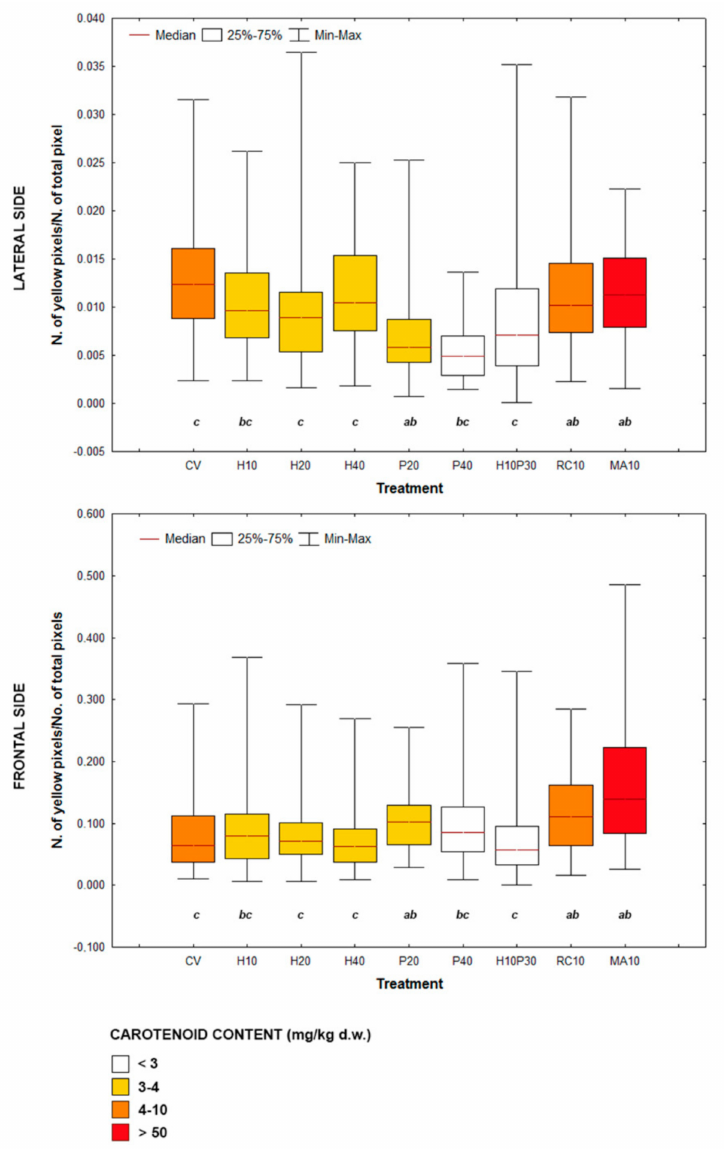
Figure 3. Box plots showing variability of the number of yellow pixels on lateral and frontal sides of experimental groups. Di ff erent letters indicate significant di ff erences among treatments (ANOSIM; p < 0.05); similar letters depict no significant di ff erences. Color shade is a measure of total carotenoids concentration in the diet. CV: vegetable control; H: Hermetia illucens ; P: poultry by-product; RC: red swamp crayfish; MA: microalgae dried